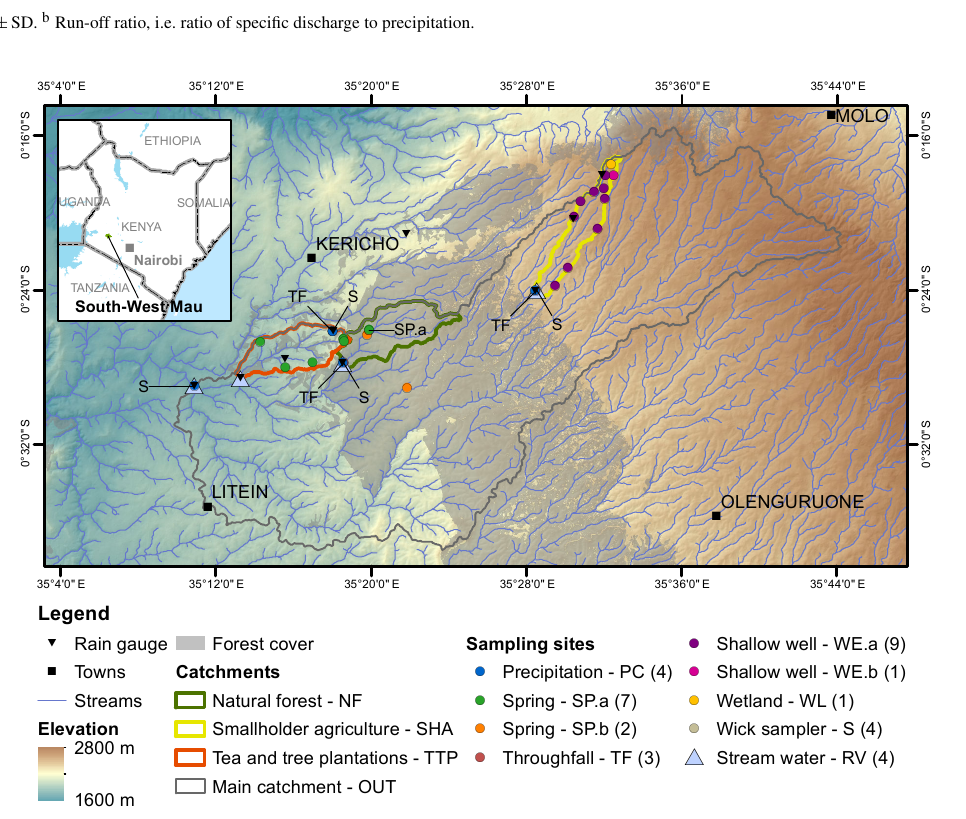
tory of Justus Liebig University Giessen, Germany, with cav- ity ring-down spectroscopy (Picarro, Santa Clara CA,